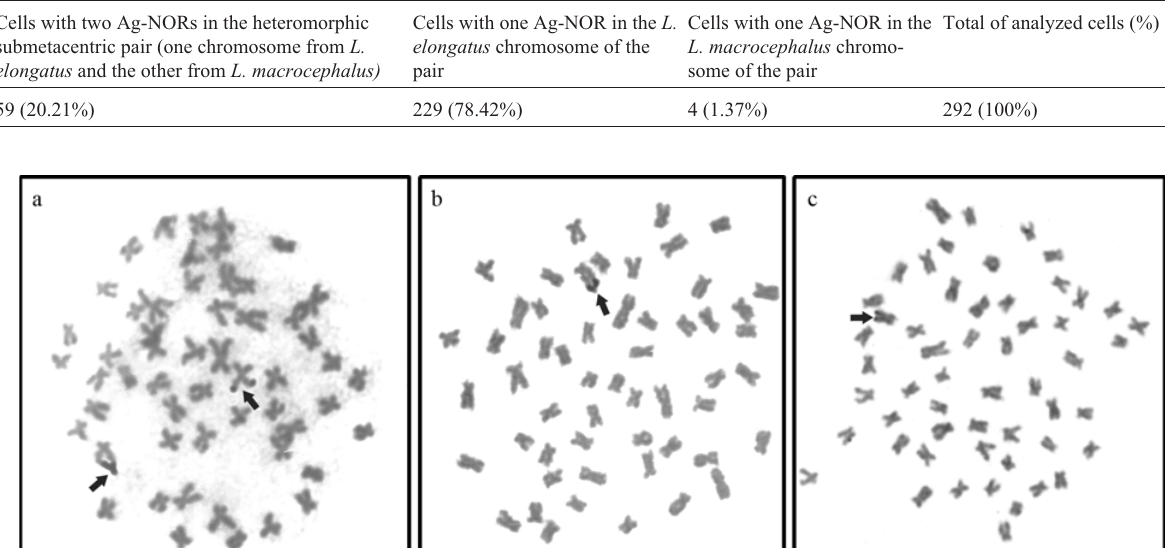
Figure 5 - Metaphases of the interspecific hybrid “Piaupara” (silver nitrate staining). In (a), a heteromorphic submetacentric chromosome pair with one homologuefrom L.elongatus (arrow)andtheotherfrom L.macrocephalus (arrow);in(b),the L.elongatus homologueofthepair(arrows);andin(c),the L. macrocephalus homologue of the heteromorphic pair (arrows)